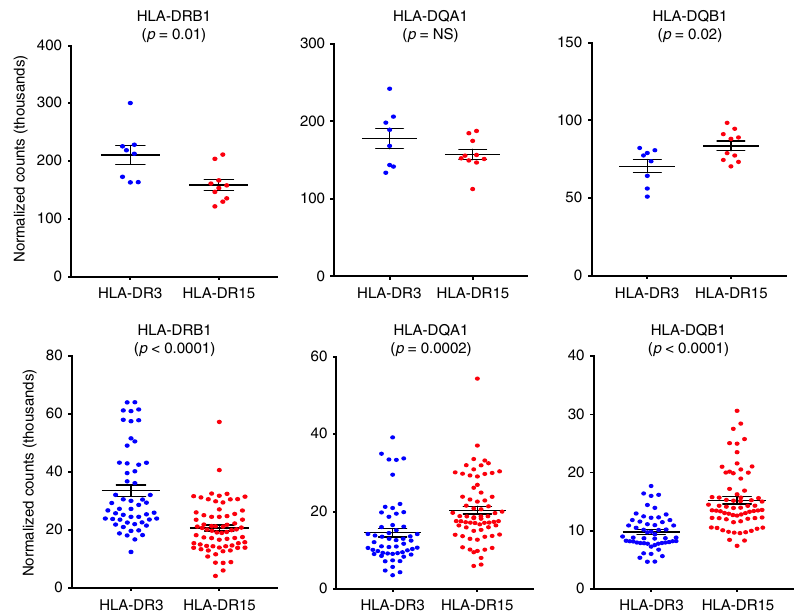
Fig. 4 Impact of HLA-DR3 and DR15 haplotypes on HLA Class II gene expression. Data presented are from our 25 LCL samples (top panel) and the European gEUVADIS dataset (bottom panel). Normalized gene counts (measured in thousands) for each gene are plotted on the y -axis and colored by risk haplotype (DR3: blue; DR15: red); risk haplotype is presented on the x -axis. Mean and standard error of the mean bars are given in